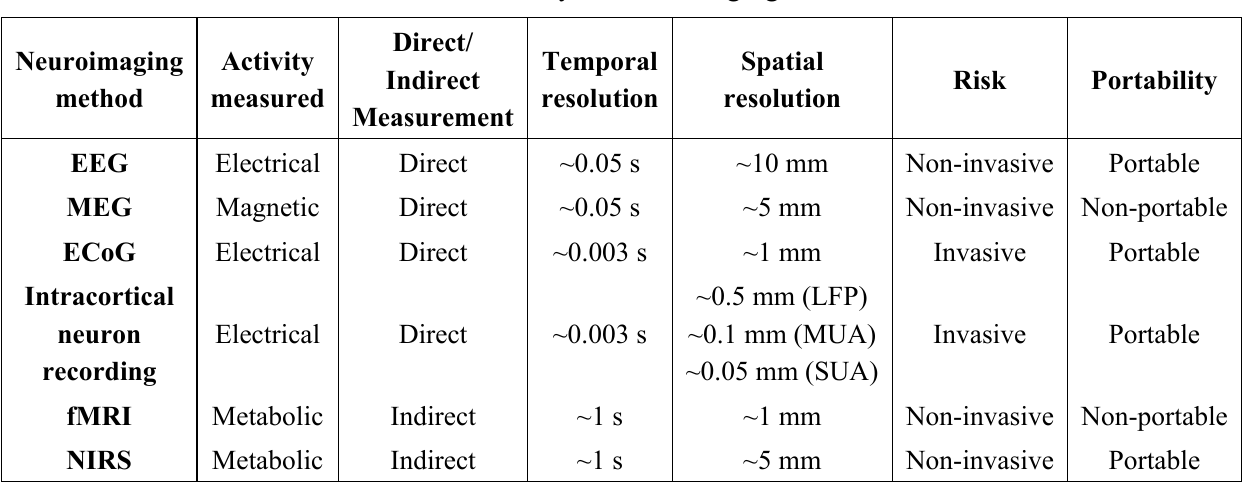
Table 1. Summary of neuroimaging